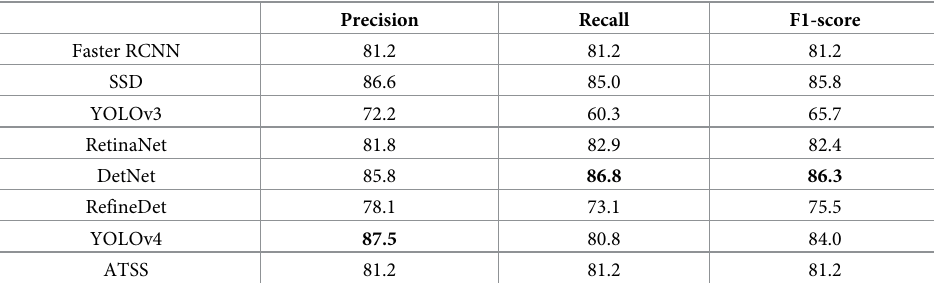
Table 7. Result for sequence-based two-class polyp